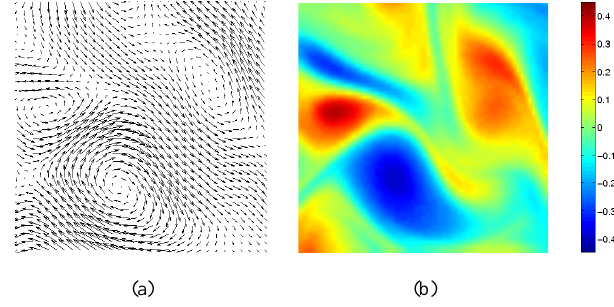
Figure 5. State example. (a) Velocity field w t ; (b) associated vor- Fig. 5: State example. (a) Velocity field w t ; (b) Associated vorticity map ξ t . ticity map ξ t